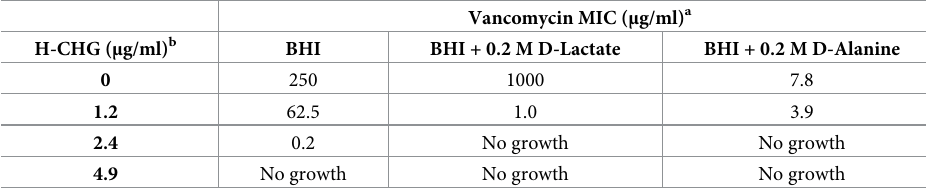
Table 2. Median vancomycin MICs in E . faecium